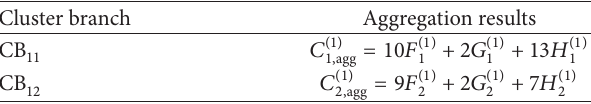
Table 2: Data processing of edge nodes.